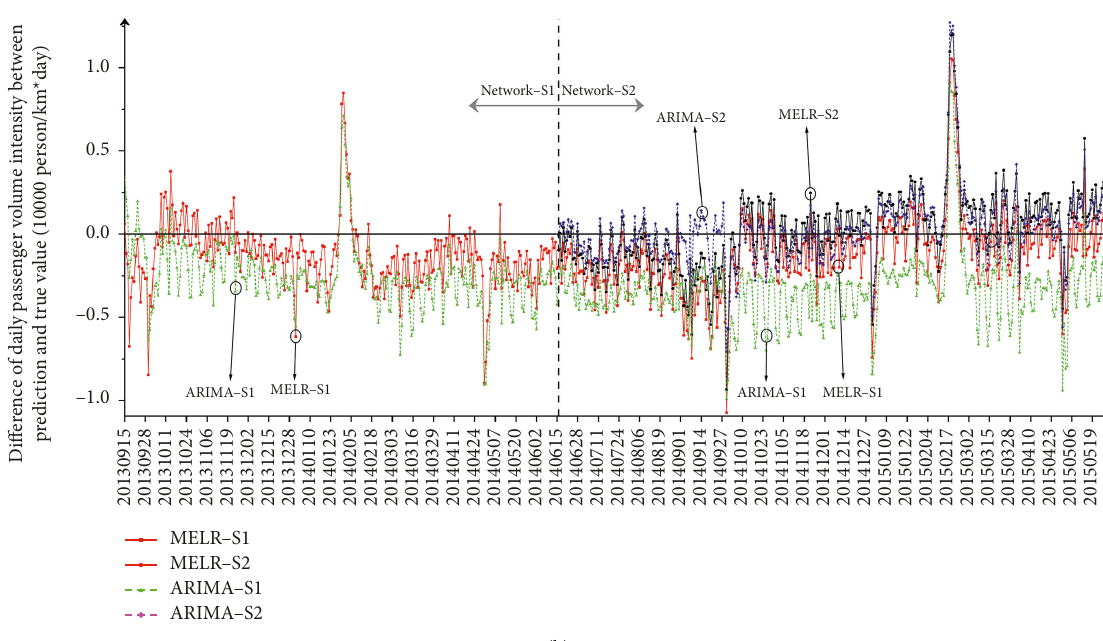
Figure 8: (a) The difference between fitting and actual daily passenger volume intensity in the initial network for MELR and ARIMA models. (b) The difference between predicted and actual daily passenger volume intensity in the initial network for MELR and ARIMA models. Table 5: Results of Wilcoxon signed-rank test and Friedman test in S1, S2, and S3. Dataset stages